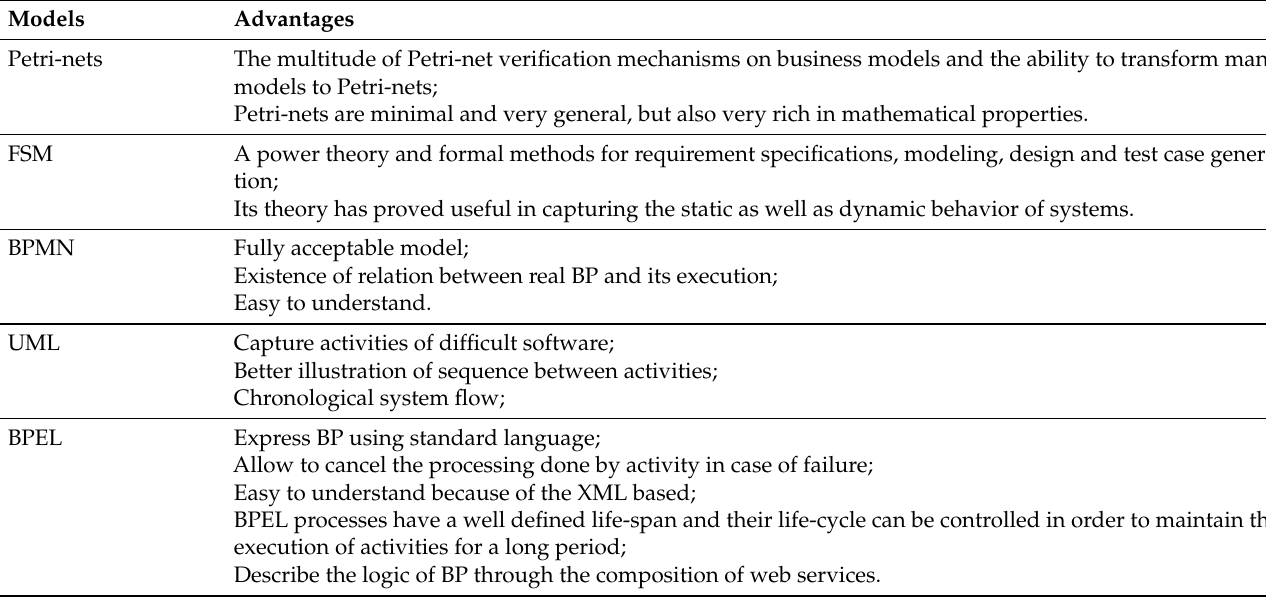
Table 1. BP models’